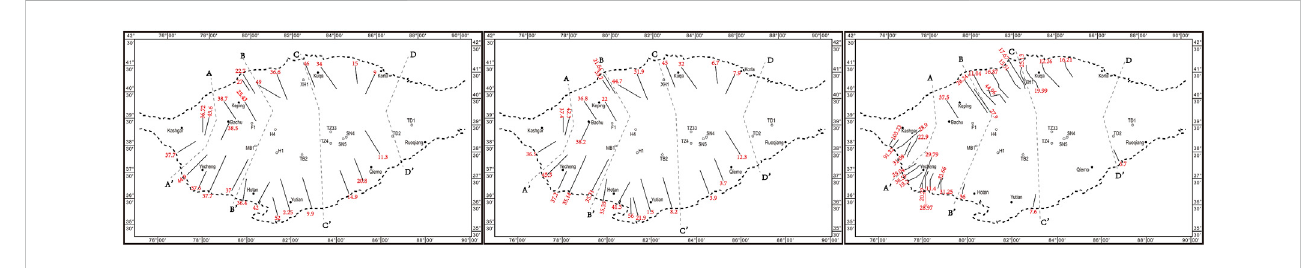
FIGURE 6 Distribution of shortening at the basin margin calculated from each seismic section.